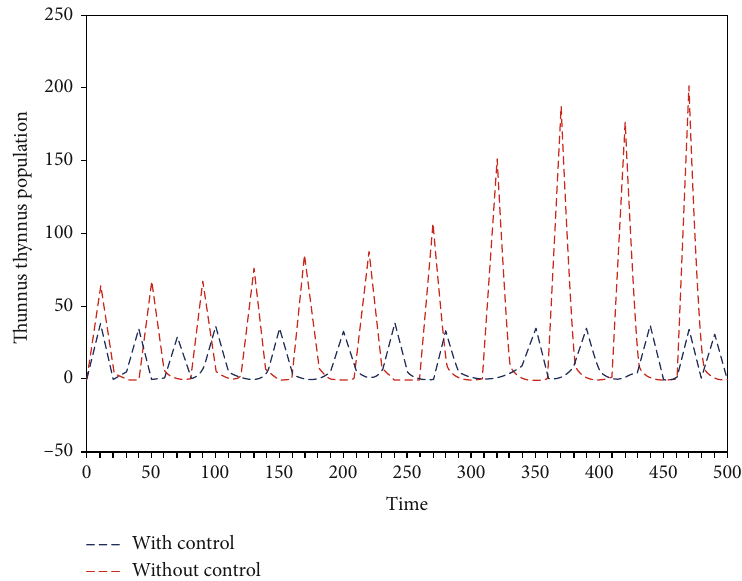
Figure 12: Thunnus thynnus population with optimal harvesting and e ff ort harvesting, with medium e ff ort.